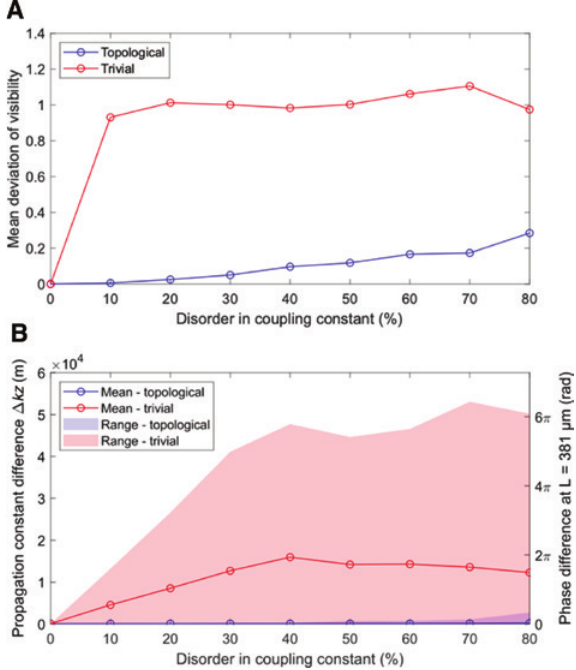
Figure 5: Effect of increasing levels of off-diagonal disorder on topological (blue) and trivial (red) lattices. (A) Mean absolute deviation from visibility = 1 for increasing values of disorder in the coupling constants (manifesting in the waveguide positions). (B) Mean and range of difference in propagation constants of the two defect modes Δ k (left) and the corresponding z phase difference at the output of the lattice (right) for increasing disorder in the coupling